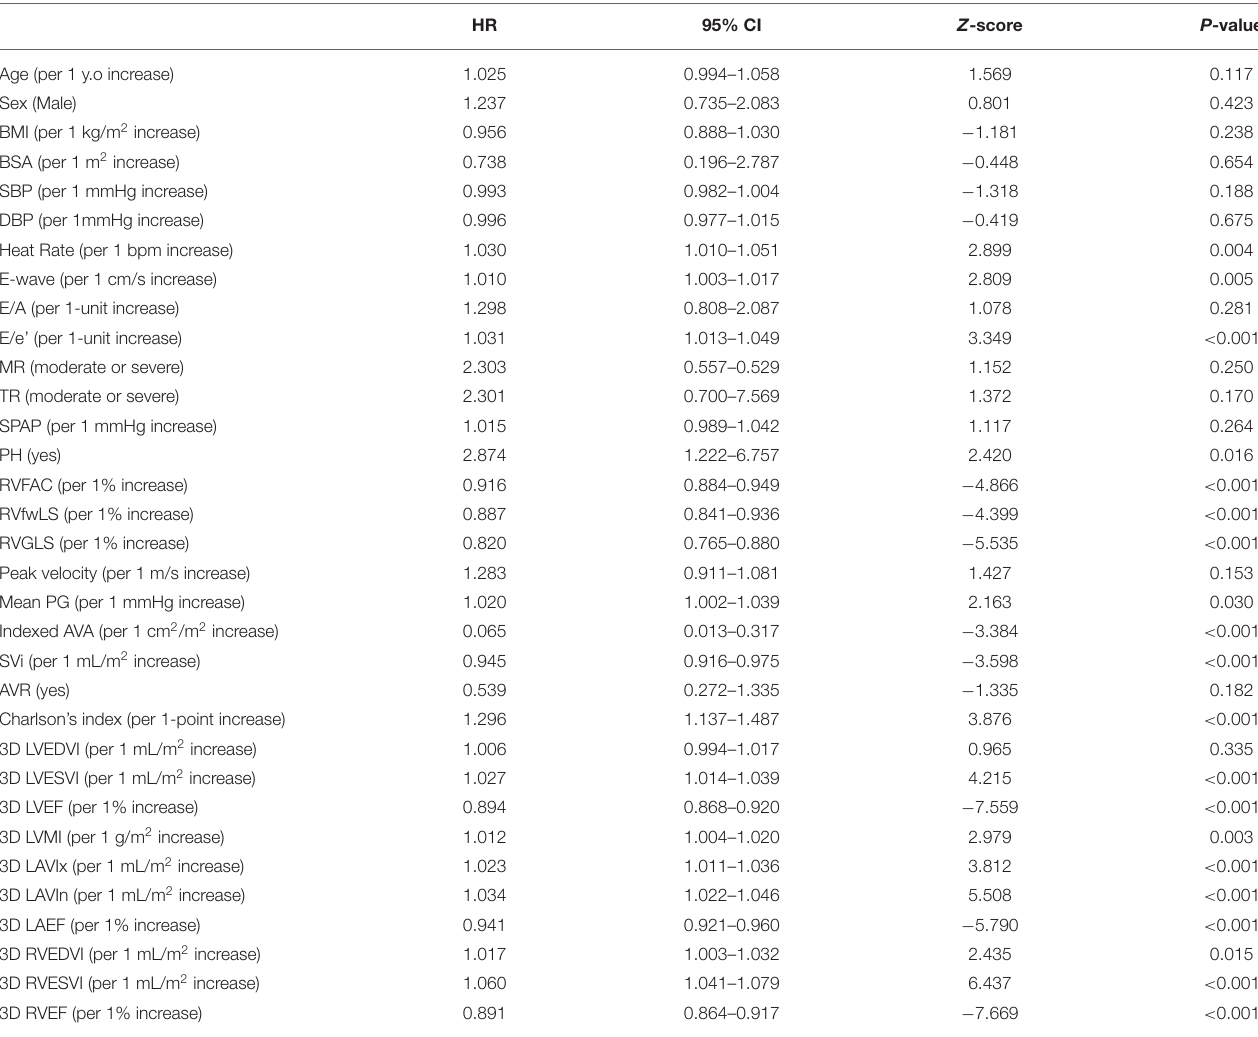
TABLE 3 | Univariate Cox regression analyses of predictors of cardiac events. HR 95% CI Z -score P